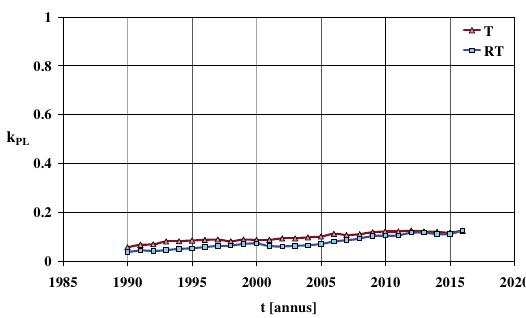
Fig. 7. Share of annual emission in Poland comparing to the annual emission in the European Union for carbon monoxide: for total emission – T and for emission from motor vehicles – RT in years 1990–2016